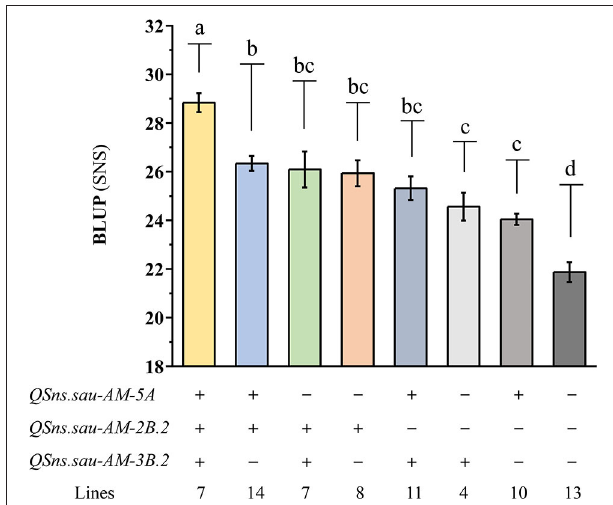
FIGURE 5 | The additive effects of QSns.sau-AM-5A , QSns.sau-AM-2B.2 , and QSns.sau-AM-3B.2 on increasing SNS. “ + ” and “–” represented haplotype group with and without the positive allele of the corresponding QTL based on the genotype of flanking markers, respectively. Letters a, b, c, and d represent a significant difference among haplotype groups.